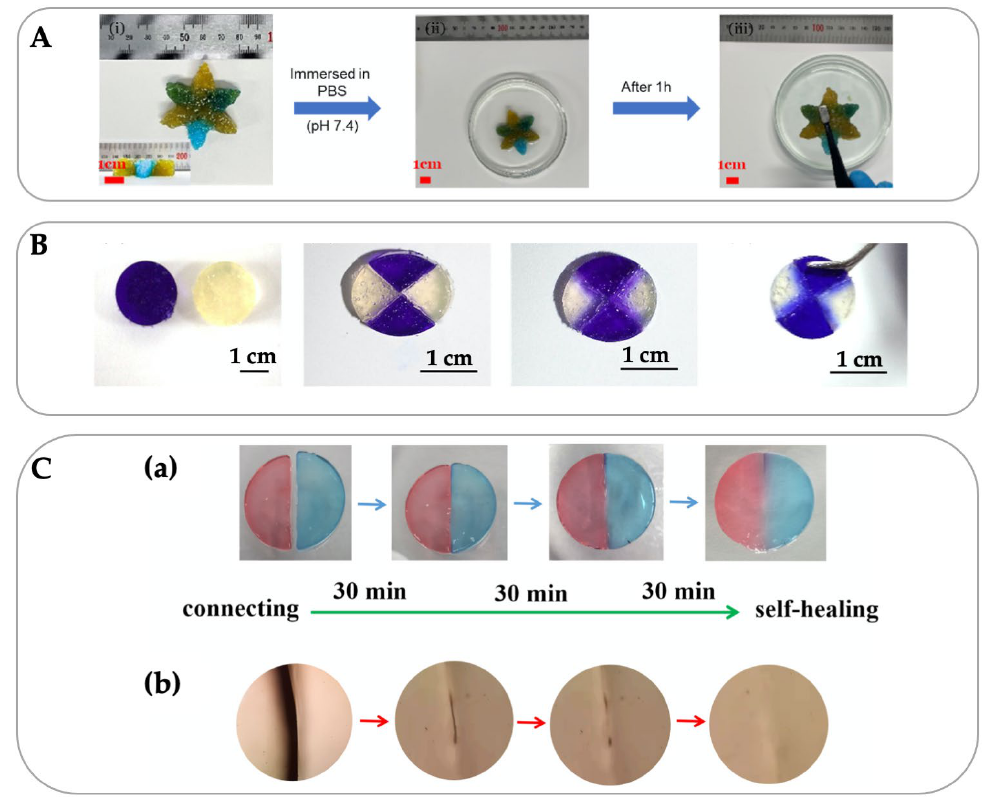
Figure 1. Self-healing property of quaternized chitosan/tannic acid/oxidant hyaluronic acid hydro- gel after 1 h ( A ) [reprinted with permission from ref. [24] Copyright © 2022, Elsevier], carboxyethyl chitosan/dibenzaldehyde-terminated poly(ethylene glycol) hydrogel after 3 h ( B ) [reprinted